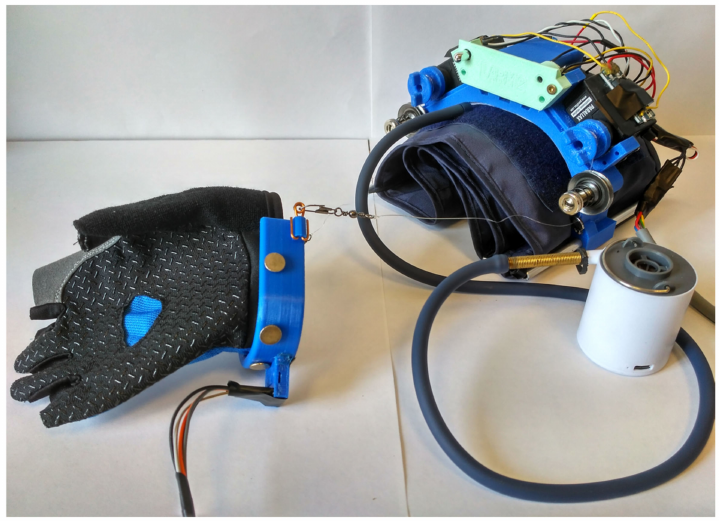
Figure 4. A prototype of L-CADELv2 with the lower and upper modules built at LARM2 in